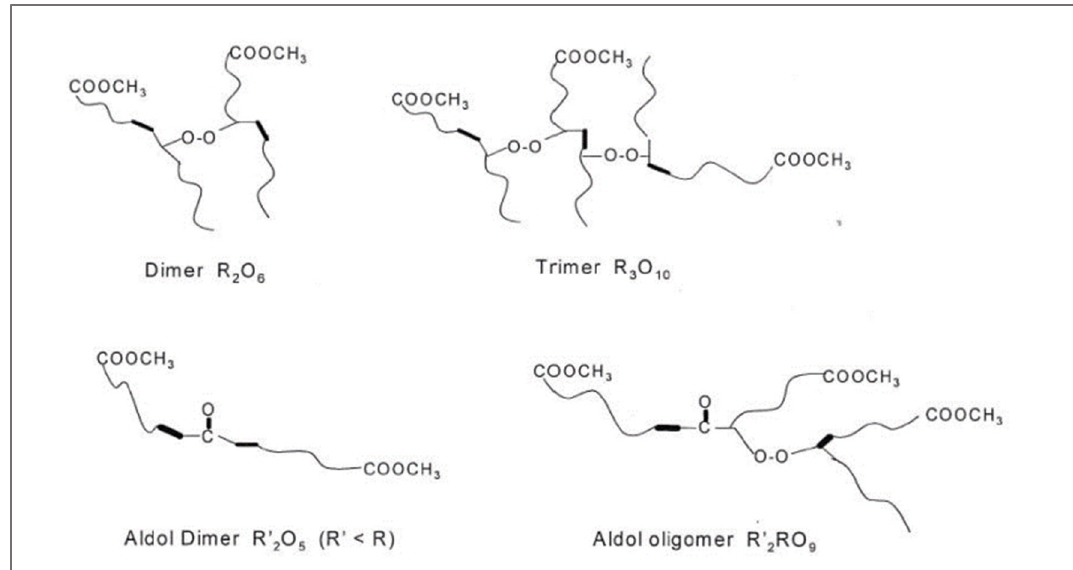
Figure 2. Types of hydroperoxide oligomers that can form, resulting in degradation of biodiesel.